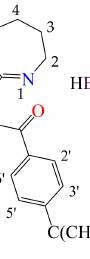
Figure 9. Compound 2a .